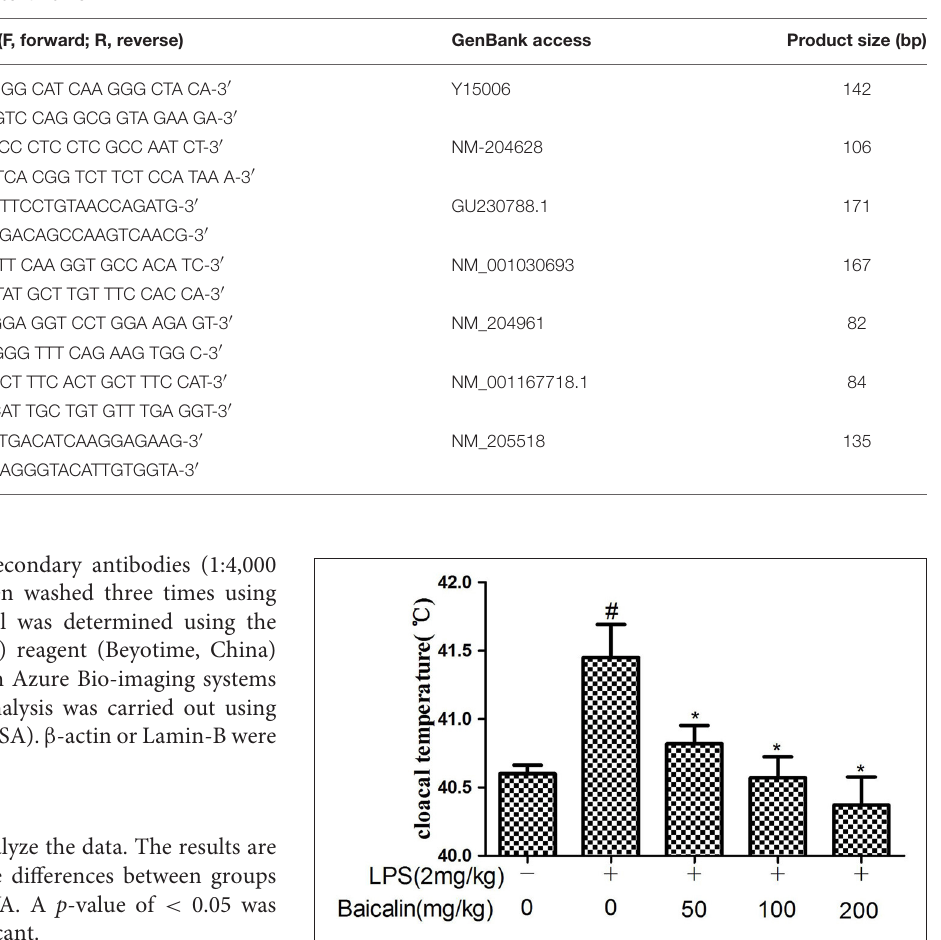
FIGURE 1 | Effects of Baicalin on LPS-induced cloacal temperature. Data are expressed as the mean ± SD . ( n = 10). * P < 0.05vs. LPS group; # P < 0.05vs. control